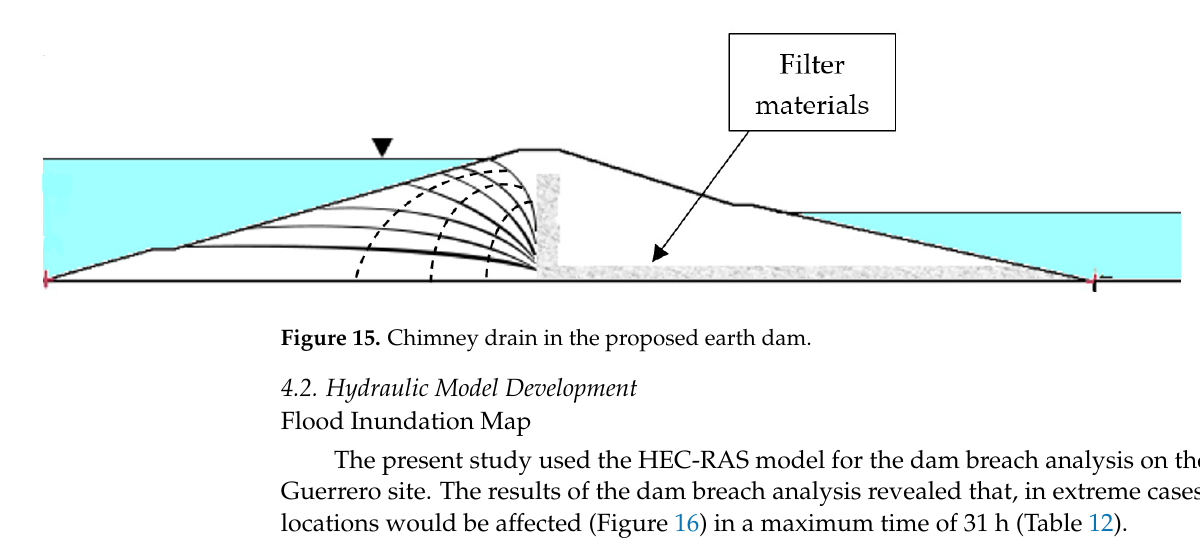
Figure 15. Chimney drain in the proposed earth dam.